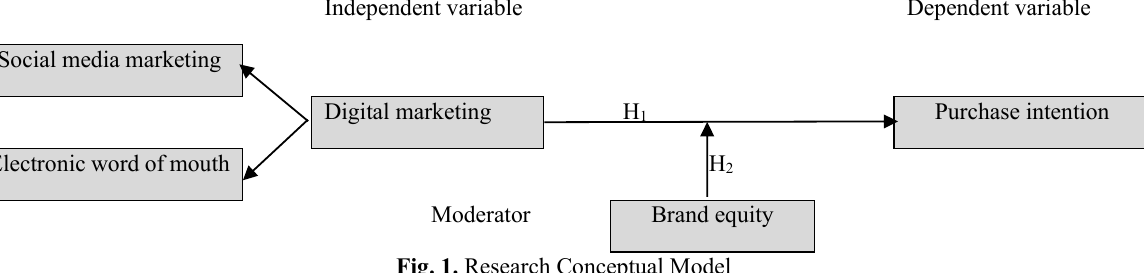
Fig. 1. Research Conceptual Model